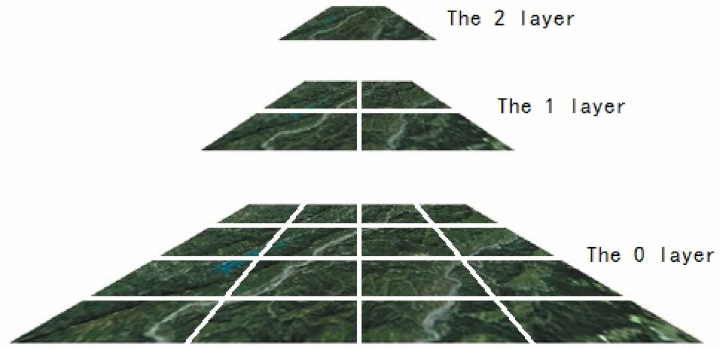
Figure 5. Image tile pyramid